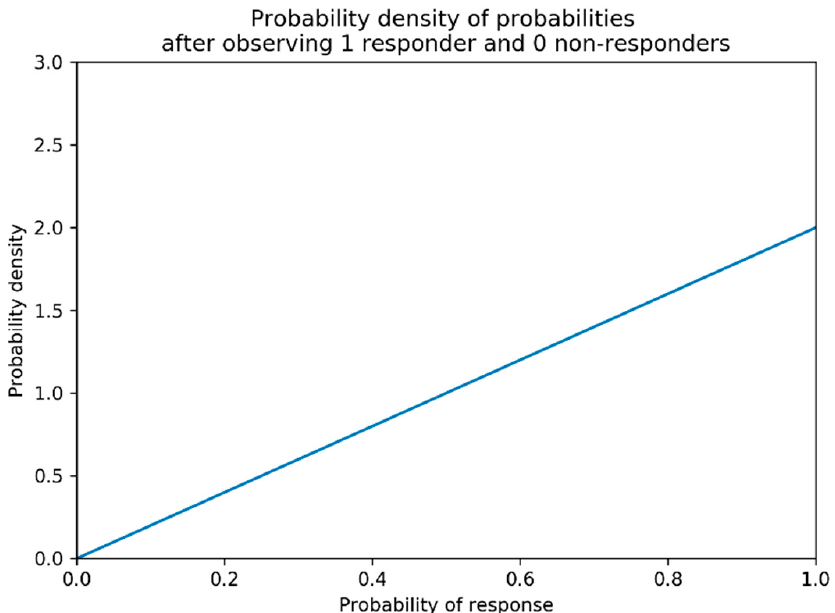
Figure 2. Probability density of probabilities of response after observing one responder and zero non-responders with no prior knowledge regarding probability of response. The higher the probability density is for a given probability of response, the more likely that it is the true probability of response given the data. The above is formally a Beta (2,1) distribution.